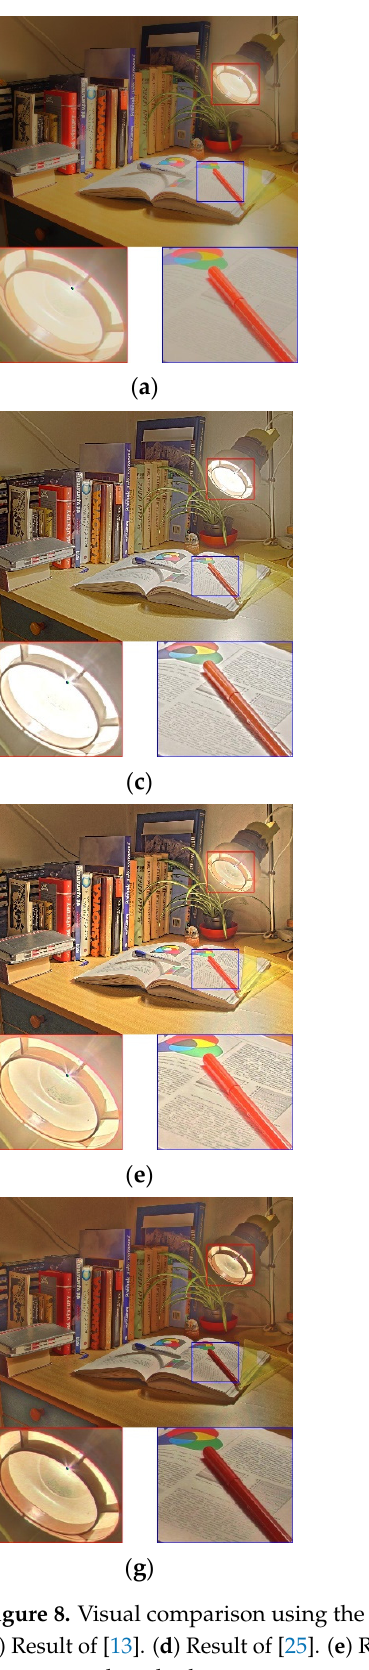
( h ) Figure 7. Visual comparison using the test image Synagoguei. ( a ) Result of [4]. ( b ) Result of [9]. ( c ) Result of [13]. ( d ) Result of [25]. ( e ) Result of [14]. ( f )Result of [17]. ( g ) Result of [18]. ( h ) Result of the proposed method. Figure 8 shows the reproduced results obtained using the Cadik_Desk02 test image. It is an indoor scene in which the lamp causes an extreme luminance difference in the captured image. In Figure 8a, the text on the book is barely perceptible because of the strong lighting. In Figure 8b,c, the detailed texture of the book is maintained; however, the global contrast in both figures is unbalanced, and the color tone is flat. In Figure 8d, the details are slightly preserved; however, some color shading occurs. In Figure 8e, the details are well retained; however, the overall appearance is over-sharpened (e.g., lampshade in red rectangle). This is because in the method of [14], the detail layer and base layer are processed separately, thereby overamplifying the detail information. In